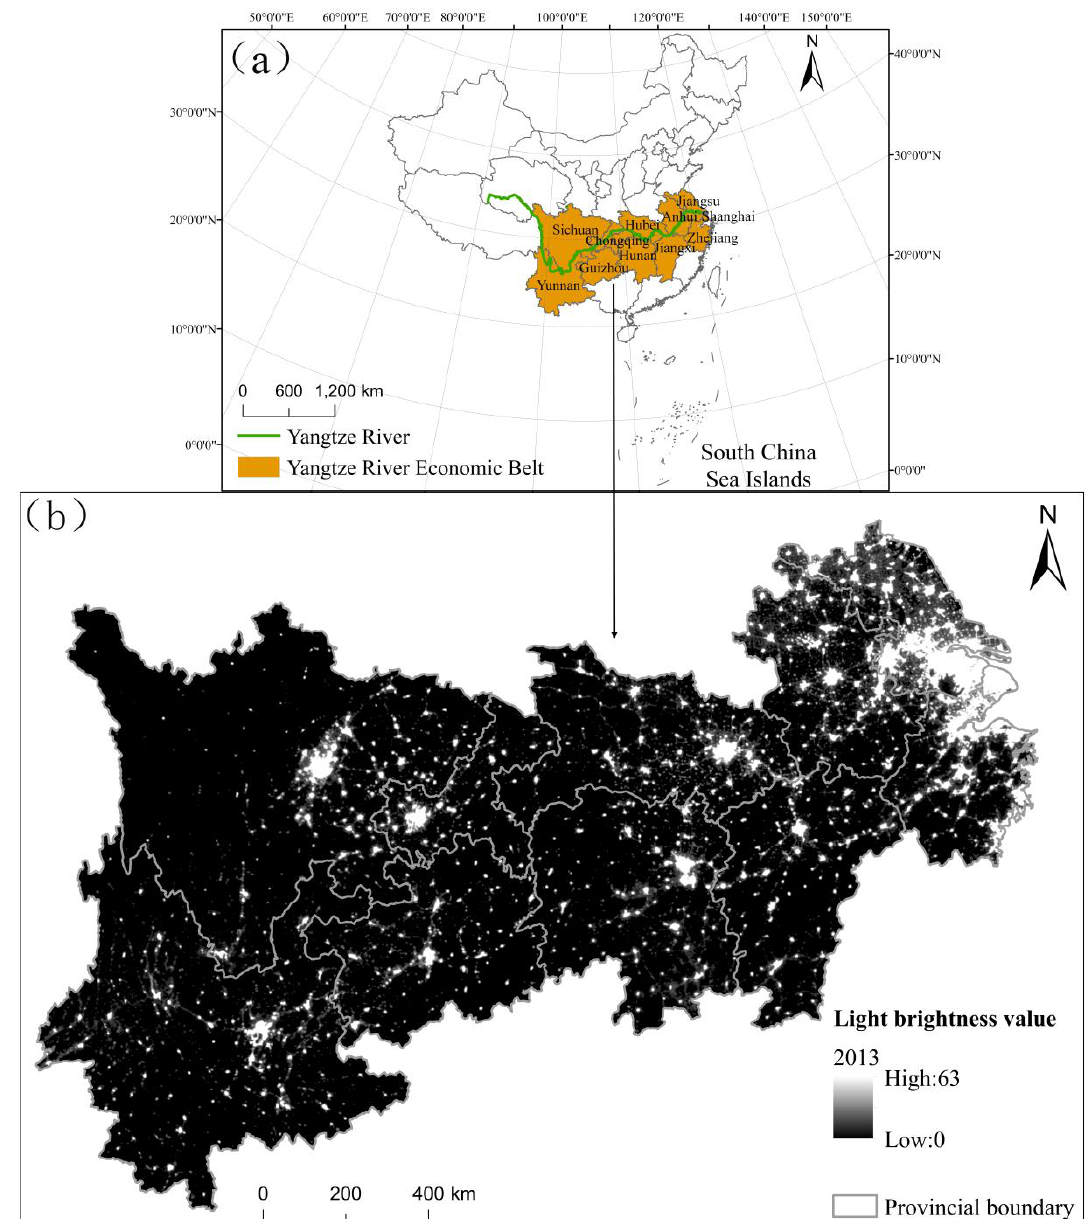
Figure 1. The Yangtze River Economic Belt (YREB) and the nighttime light intensity map of 2013. ( a ) Introduction to the geographical location of the YREB, ( b ) Night light intensity map of the YREB in 2013.